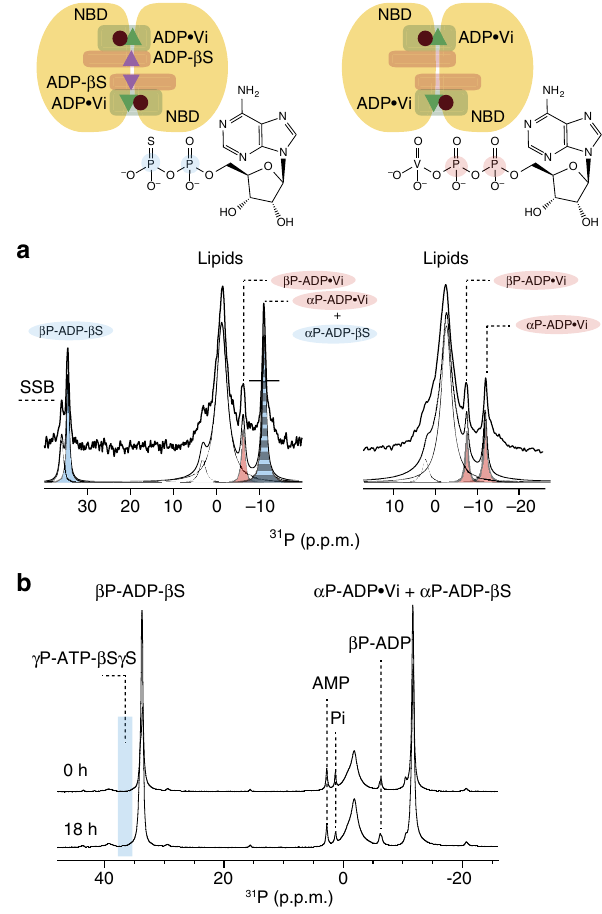
Figure 4 | ADP.Vi-trapped MsbA with bound ADP- b S. ( a ) Cross-polarized (CP) 31 P-MAS NMR allows to observe bound ADP.Vi at (cid:2) 6.2 and (cid:2) 10.9 p.p.m. (right). Upon addition of excess of ADP- b S, an additional resonance at 34.5 p.p.m. corresponding to b P-ADP- b S is observed. Furthermore, the peak at (cid:2) 11.0 p.p.m. doubles because of the overlap of a P-ADP- b S and aP-ADP.Vi. Peak deconvolution reveals the same integral peak intensities for ADP- b S and ADP.Vi, indicative of a 1:1 stoichiometry. ( b ) Directly polarized 31 P-MAS NMR spectra of MsbA in complex with ADP- b S and ADP.Vi shows that no g P-ATP- b S g S is produced as shown in Fig. 2. Spectra were recorded under the same conditions as described in the Methods. The nominal temperature in a was set to 260K and in b to 270K. SSB refers to spinning